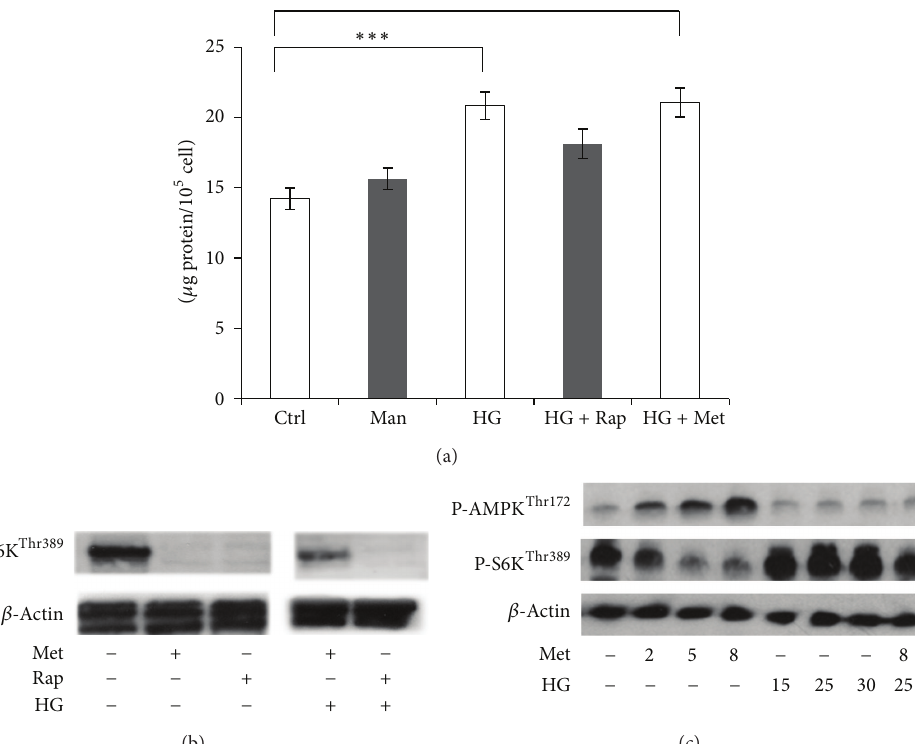
Figure 5: (a) Rapamycin and metformin differentially affect high glucose-induced total protein synthesis. HEK293 cells were incubated with 5.5 mM D-glucose (Ctrl), 5.5 mM D-glucose + 24.5 mM mannitol (Man), and 30 mM D-glucose (HG) for 48h. For the last 24 h, 100nM rapamycin(Rap)and8 mMmetformin(Met)wereaddedtoHG-treatedconditions.Theresultsexpressedasmean+SEMoffourindependent experiments. ∗∗∗ 𝑃 < 0.001 . (b) Metformin (Met) and rapamycin (Rap) differentially affect S6K phosphorylation in high glucose pretreated HEK293 cells. The cells were incubated with 5.5 mM (NG) or 30 mM D-glucose (HG) for 3 days. For the last 24 h, 8mM metformin (Met) or 100nM rapamycin (Rap) was added. The expression of the indicated proteins was analysed by western blotting. (c) Western blot results of the effect of metformin and high glucose on AMPK and S6K phosphorylation. HEK293 cells were cultured in normal medium supplemented with 5.5 mM D-glucose. At the indicated final concentrations, (mM) metformin (Met) and D-glucose (HG) were added for 24 h and three days,